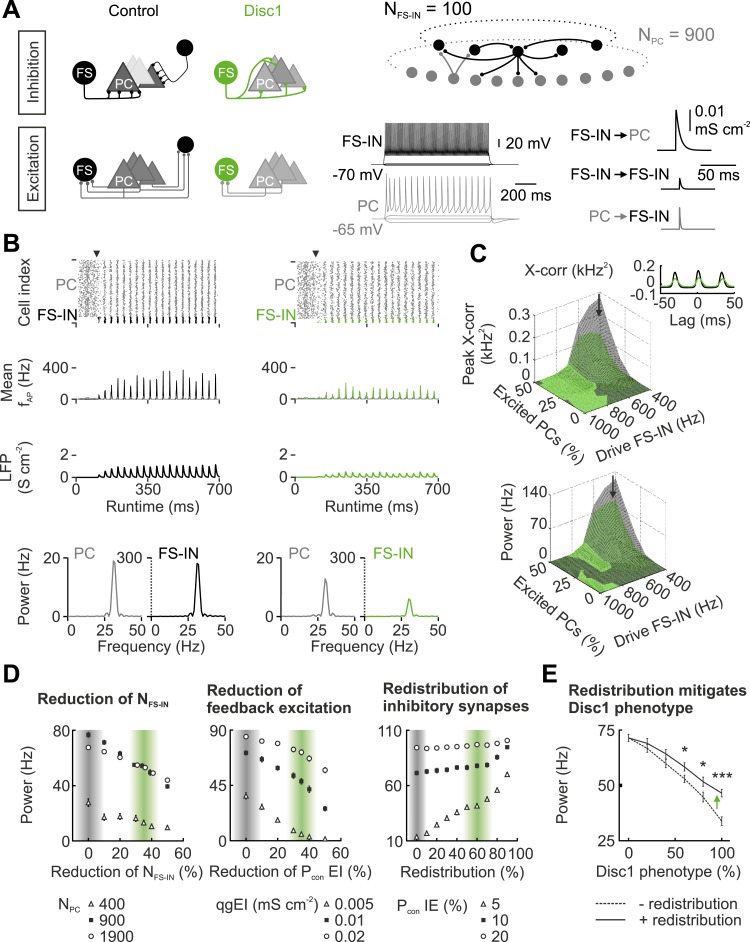
Disc1-mediated circuit changes impair low-gamma power in a network model.(A) Schematic of network structure, cellular and synaptic properties of the control (black) and Disc1 circuit (green). (B) After synapses are enabled (arrowhead), networks synchronize in the low-gamma range. From top to bottom: Raster plots representing action potentials; binned spike frequencies; LFPs; power of firing rates. (C) Cross-correlation of PC and FS-IN activity and power under different regimes of Poisson-distributed excitatory drives. Arrows point to simulation in (B). Inset, PC-FS-IN spike cross-correlogram. (D) Effects of separate Disc1-induced circuit changes on low-gamma power. Left, effect of fewer FS-INs at different PC population sizes. Middle, reduced feedback excitation expressed as connection probability (Pcon) for different E-I quantal conductances (qg). Right, redistribution of inhibitory synapses (reduction of release sites/connection with proportional increase in Pcon I-E for networks with different mean connection probabilities). Shaded bars indicate control and Disc1 parameters. Filled squares represent the default network. (E) Low-gamma power depends on the strength of the Disc1 phenotype. Dashed line: reduced NFS-IN and Pcon EI. Continuous line: additional redistribution of inhibitory synapses. *p < 0.05, #p < 0.001.